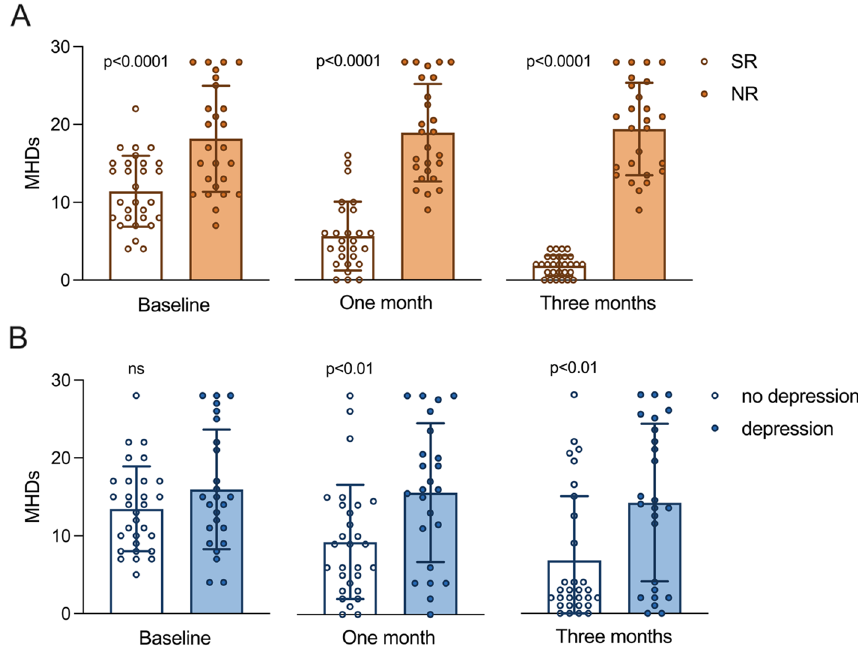
Fig. 1 Pattern of monthly headache days over three months of CGRP-mAb therapy. A In Super-Responders and Non-Responders. B In patients with and without concomitant depression. NR were significantly more likely to have concomitant